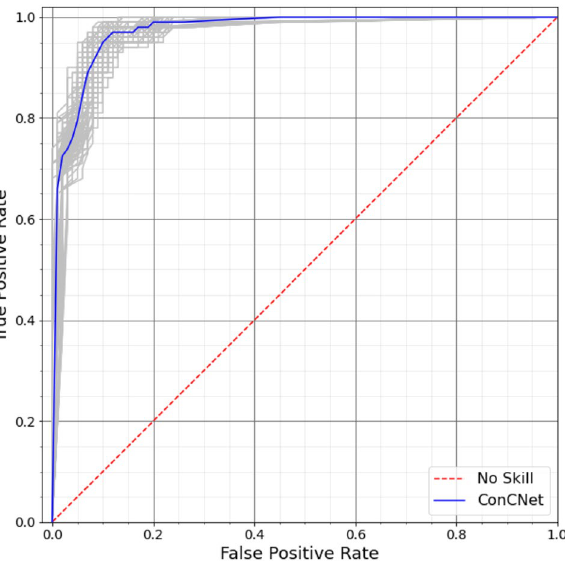
Figure 4. The Receiver Operating Characteristic (ROC) curves for the 100 LSTM networks. The grey curves show the results for each of the 100 networks and the blue curve shows the median. The ensemble median Area Under the Curve (AUC) is 0.971 (the 25% and the 75% percentile are 0.963 and 0.975, respectively). A classifier with no better accuracy than chance would be expected to have an AUC of 0.5, while an AUC of 1 corresponds to a classifier with perfect accuracy. A value of > 0.96 indicates a classifier with excellent discriminatory ability 78 . ( Plotted with Matplotlib v3.2.1 75 ).